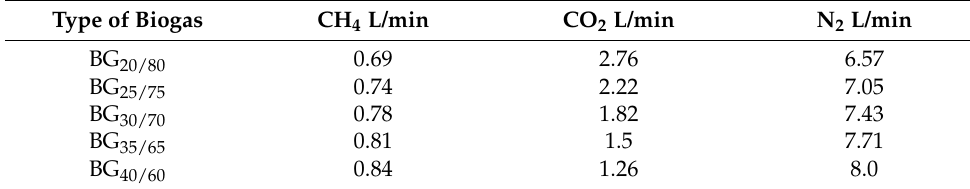
Table 1. Flows of the gas components of different biogas variants.